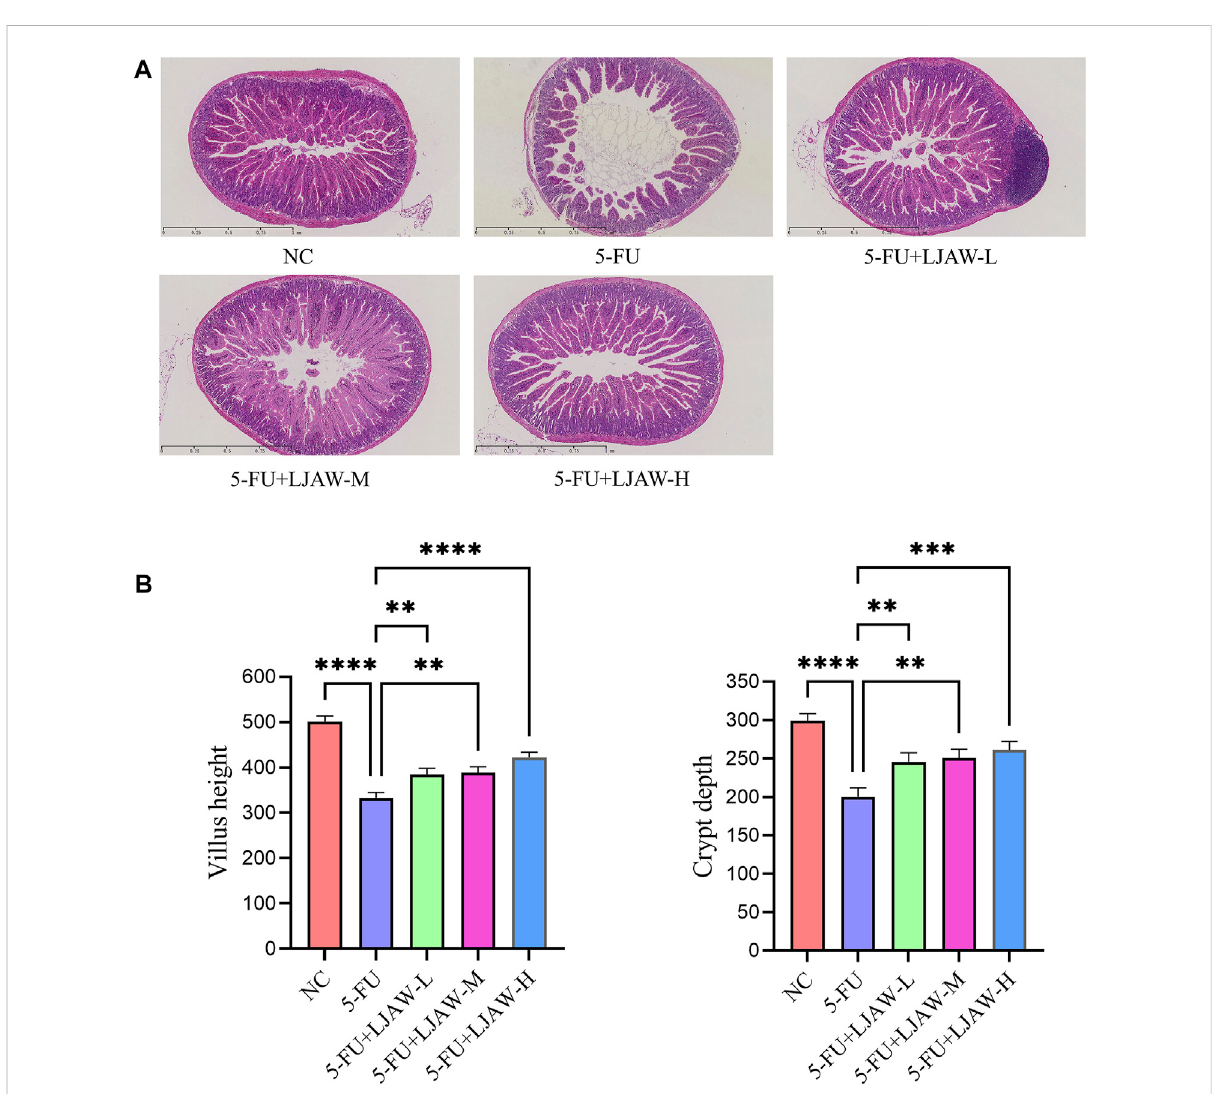
FIGURE 1 Protective effect of LJAW on 5-FU-induced small intestine injury (A) Effect of different doses of LJAW on the morphology of small intestinal mucosainmice.NC:thenormalcontrolgroup,5-FU:themodelgroup,5-FU+LJAW-H:the5-FU+LJAWhigh-dosegroup,5-FU+LJAW-M:the5- FU + LJAW medium-dose group, 5-FU + LJAW-L: the 5-FU + LJAW low-dose group. (B) Comparison of villus height and crypt depth in different groups. Data are expressed as means ± SD (n = 3). ** p < 0.01, *** p < 0.001 and **** p < 0.0001 compared with the 5-FU